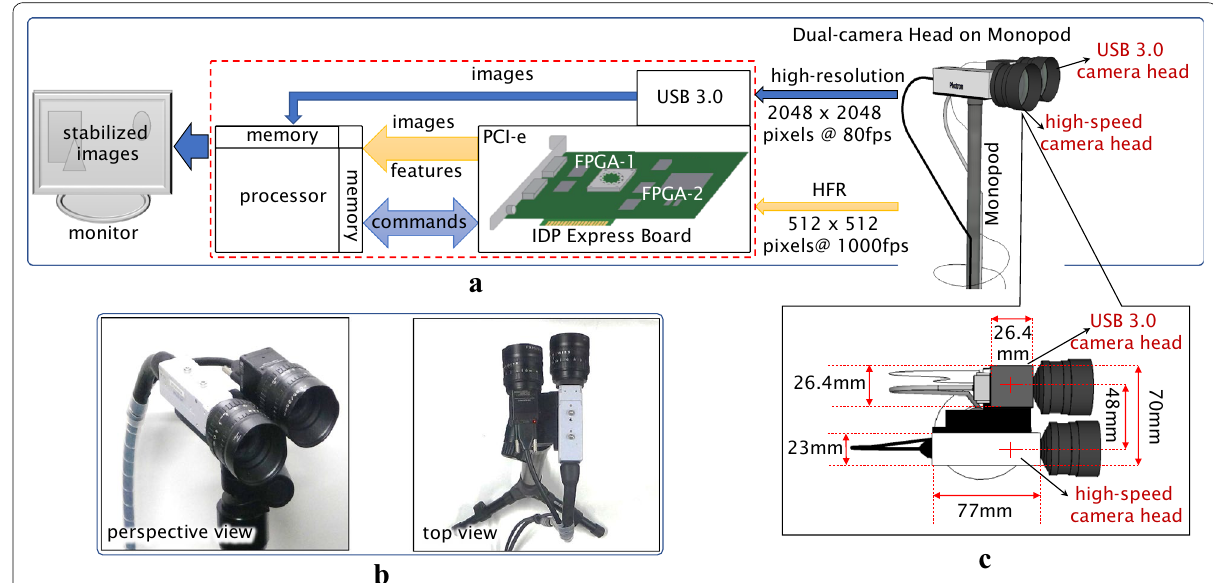
Fig. 1 Hybrid-camera system for real-time video stabilization a configuration, b dual-camera head, c top-view geometric configuration